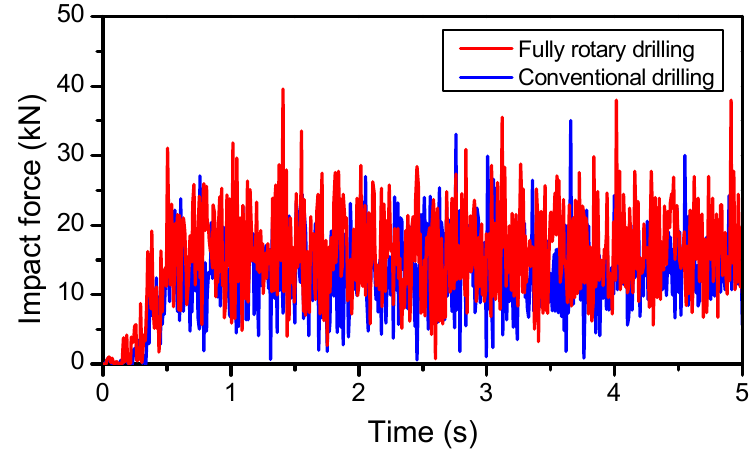
Figure 8. Torque versus time on drill-string for both fully rotary and conventional drilling.